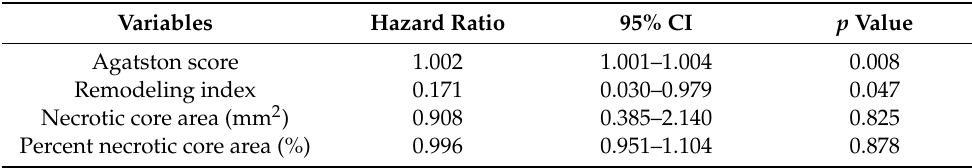
Table 3. Multivariate Cox-Proportional hazard analysis.